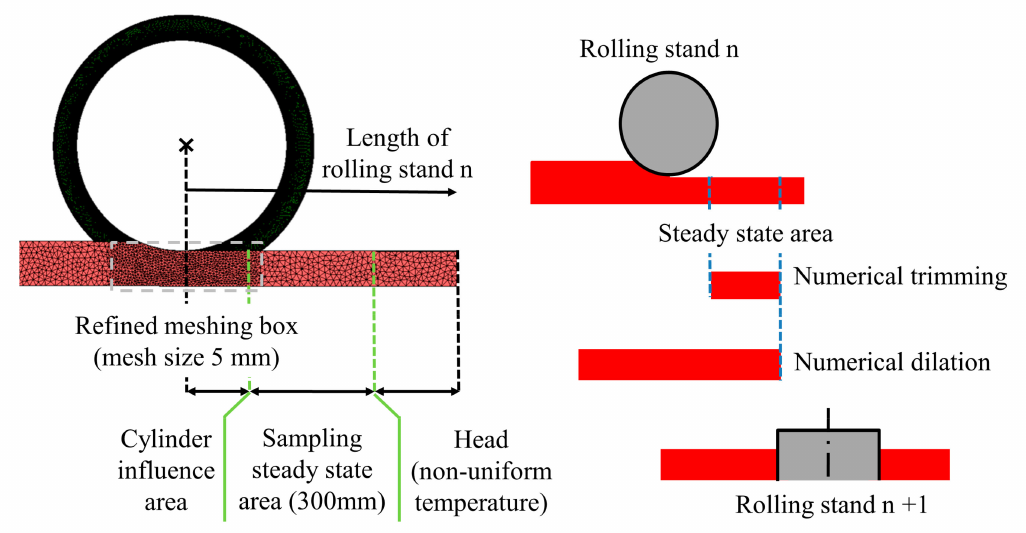
Figure 2. Meshing details and strategy of modelling of the industrial rolling of bars.